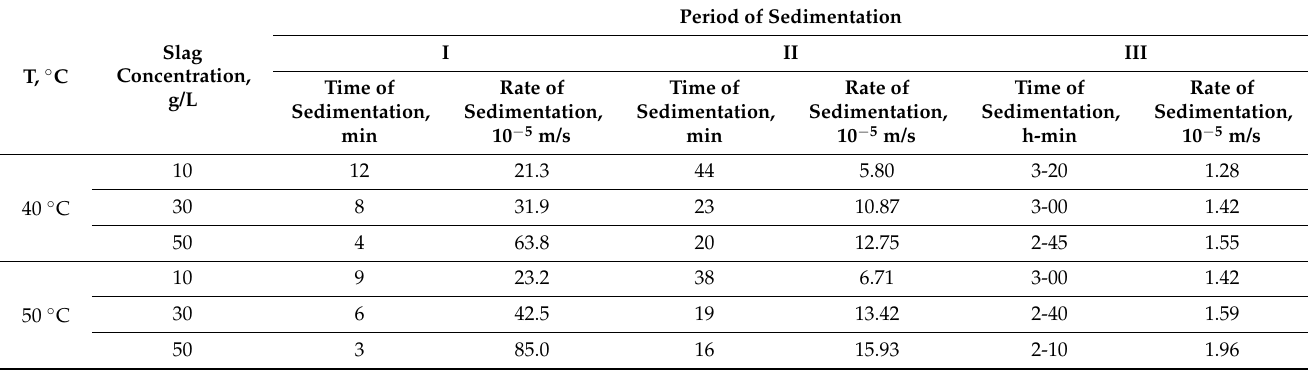
Table 10. Time and rate of sedimentation of slag particles in water medium after ultrasonic processing under improper